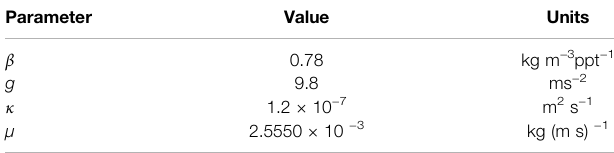
TABLE 1 | Parameters for Rayleigh number calculation.